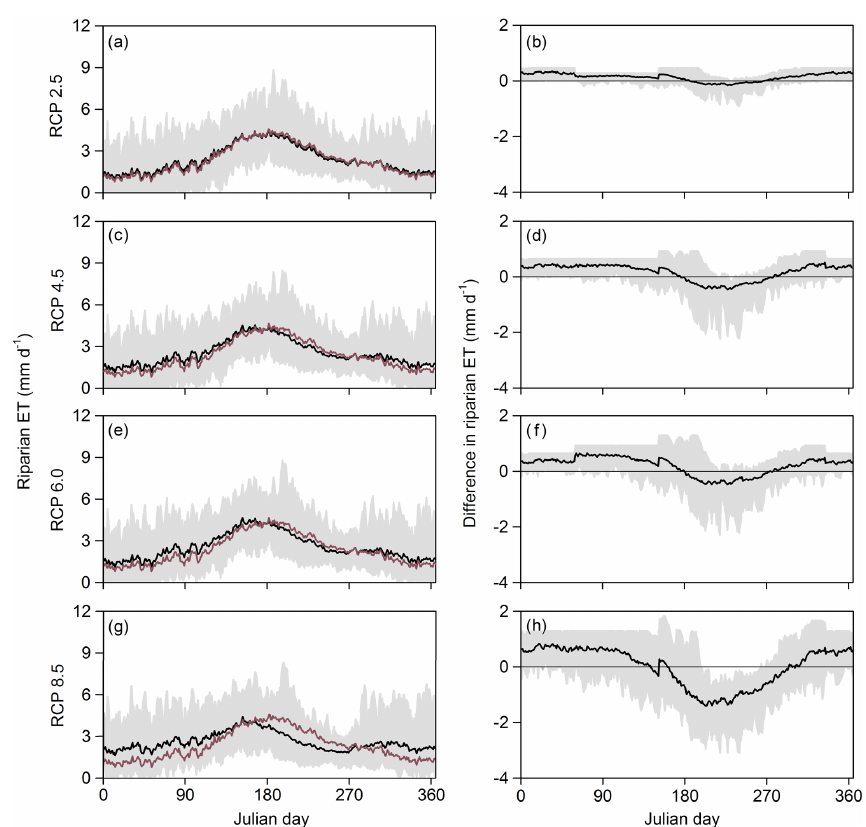
Figure 5. Seasonal pattern of (a, c, e, g) daily riparian evapotranspiration rates simulated for different climate change scenarios and (b, d, f, h) difference in the simulated values of daily riparian evapotranspiration between the reference period (1981–2000) and future climate scenar- ios (2081–2100). All the climate change scenarios were based on the RCP projections provided by the IPCC (2013) for the period 2081–2100 (Table 2): (a, b) percentile 0.25 of RCP2.5 (the most moderate scenario), (c, d) percentile 0.5 of RCP4.5, (e, f) percentile 0.5 of RCP6.0, and (g, h) percentile 0.75 of RCP8.5 (the most extreme scenario). Black lines are mean values and grey shadows indicate the maximum– minimum range of values simulated for the 20-year period. The red line in the left panels is the mean daily values of riparian ET for the reference period. The horizontal line in the right panel is shown as a